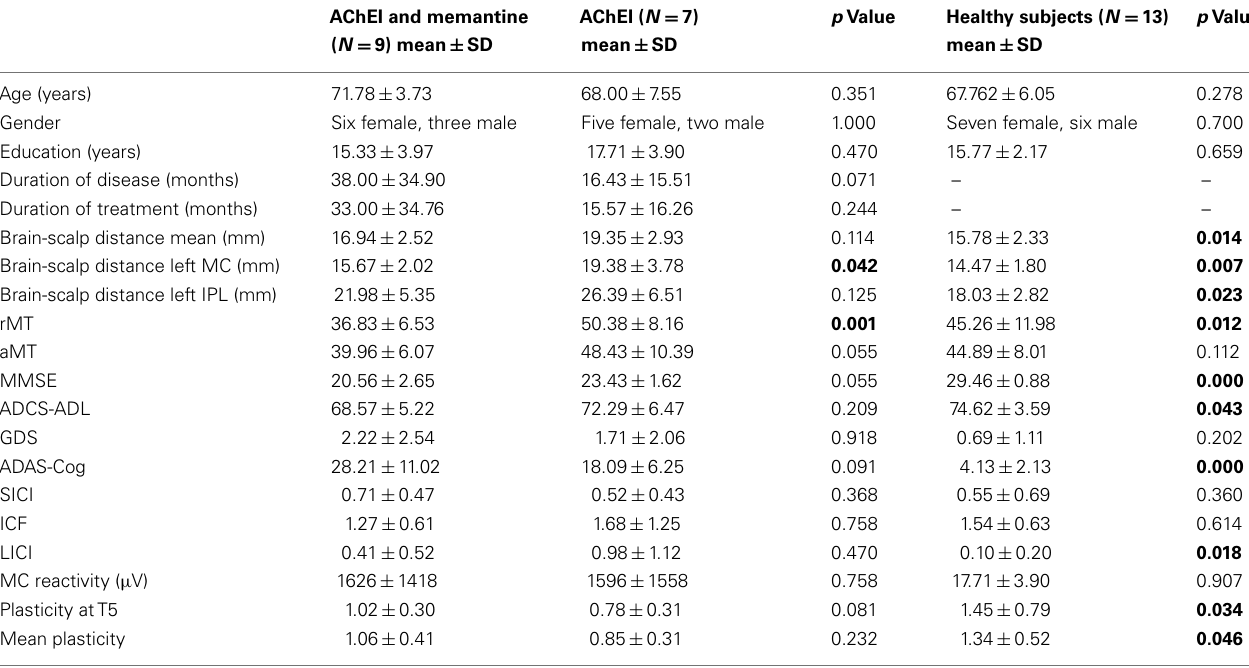
Table 1 | Demographic, pharmacological, neuropsychological, morphometric, and neurophysiological features of study